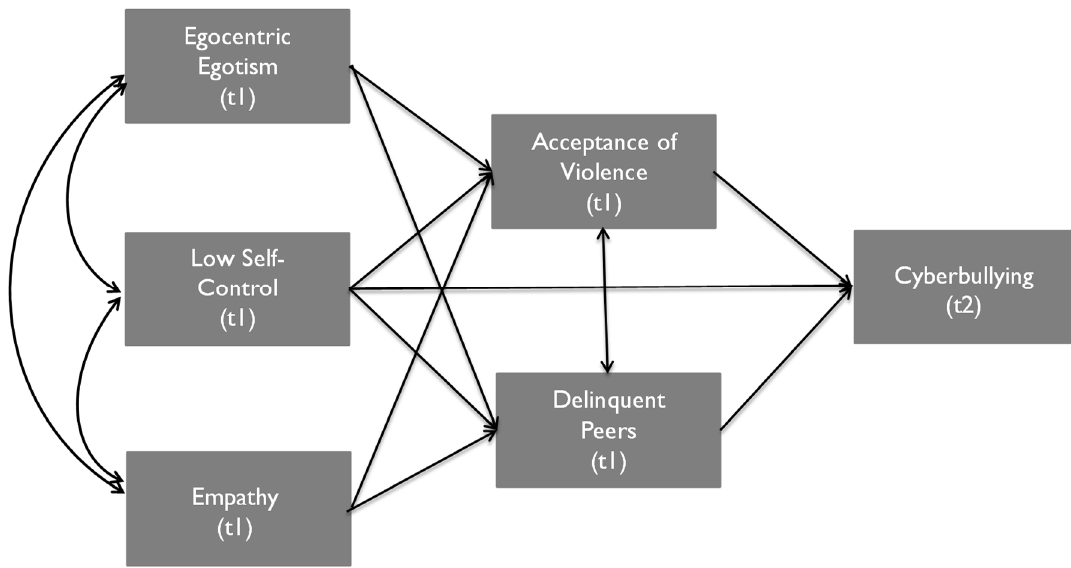
Figure 1. Underlying developmental path model for the youth cohort illustrating the derived hypotheses.